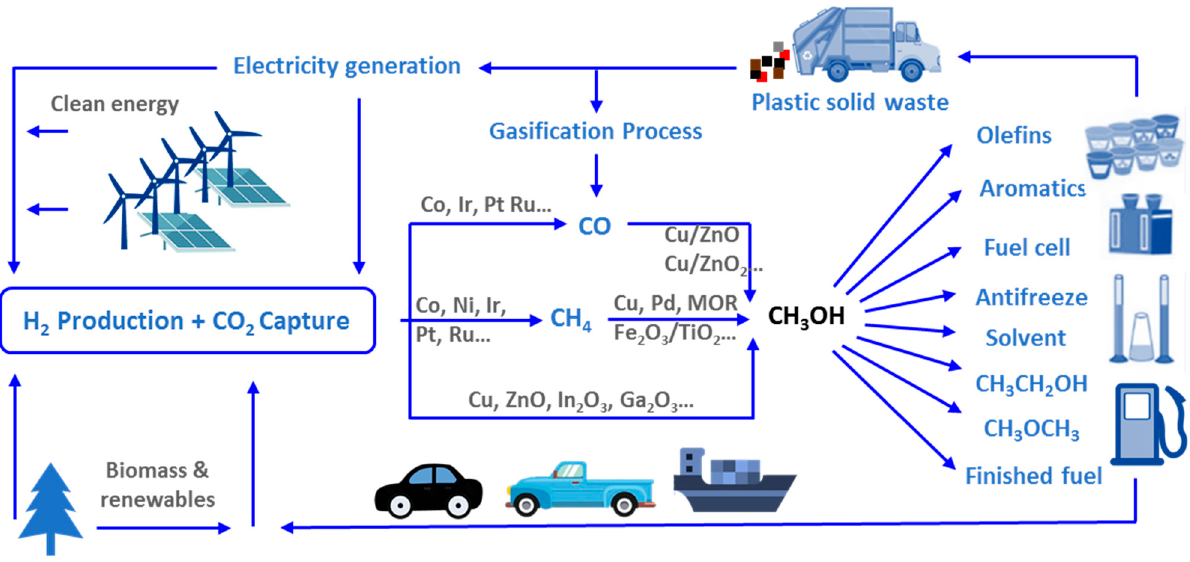
Figure 16. The simplified carbon cycle with green methanol as a platform molecule in the future. Adapted from ref.